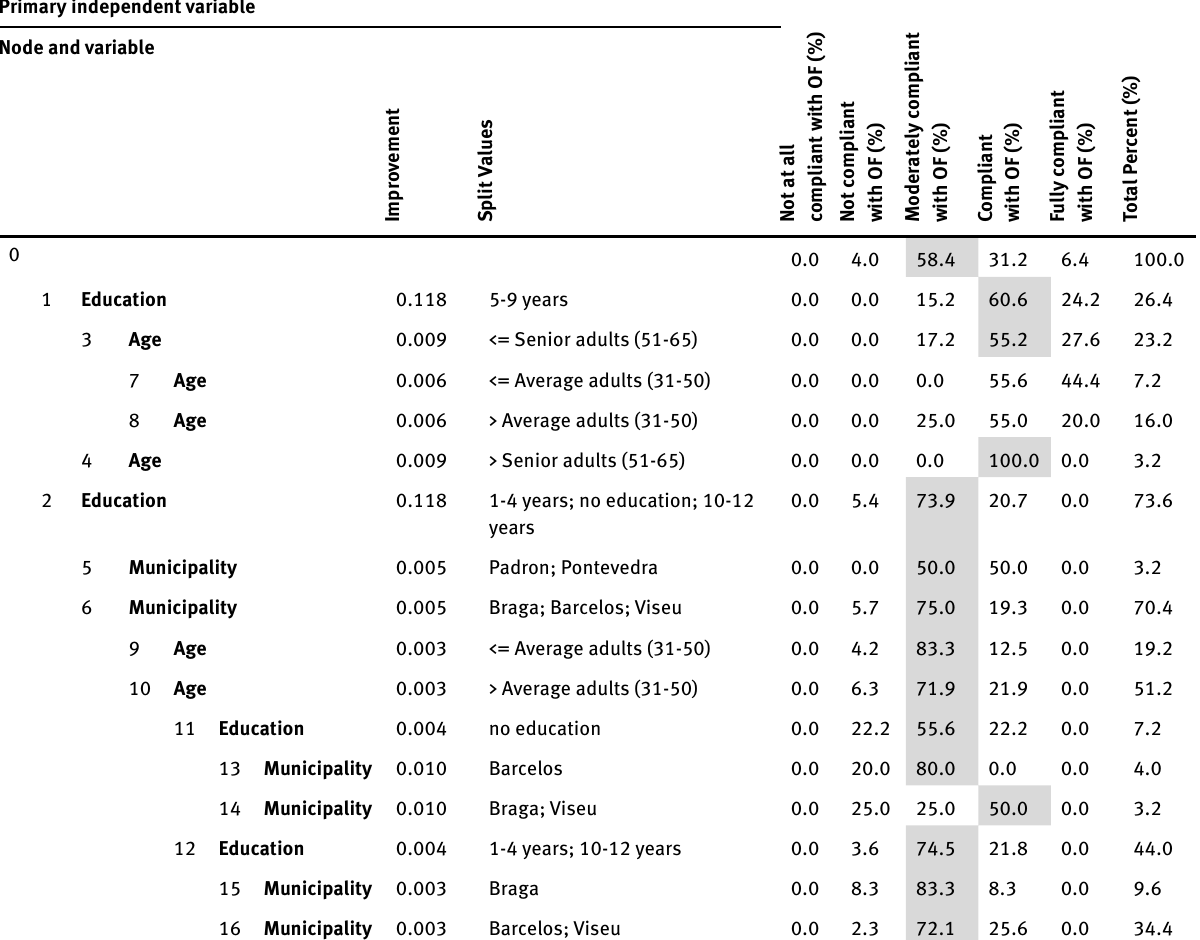
Table 5: Tree table for variable compliance with OF regarding soil management and preparation (CPOF-S) Primary independent